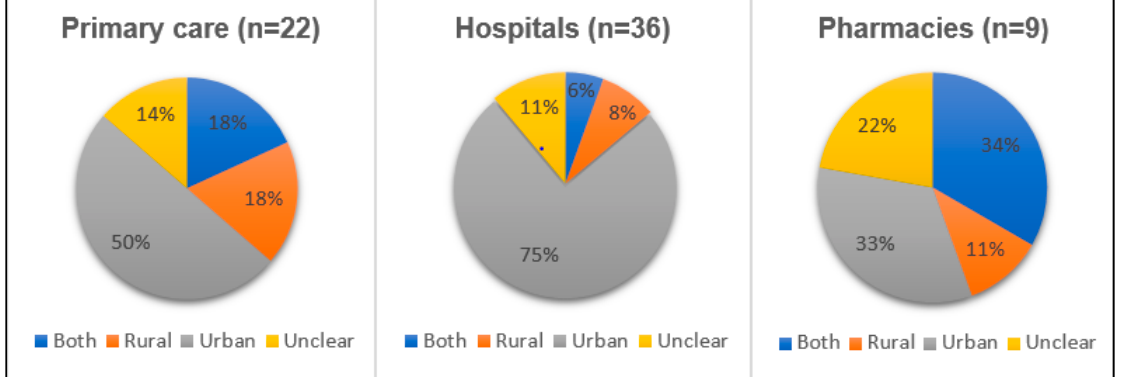
Figure 2. Location (urban or rural) where intervention was tried, by type of health setting .